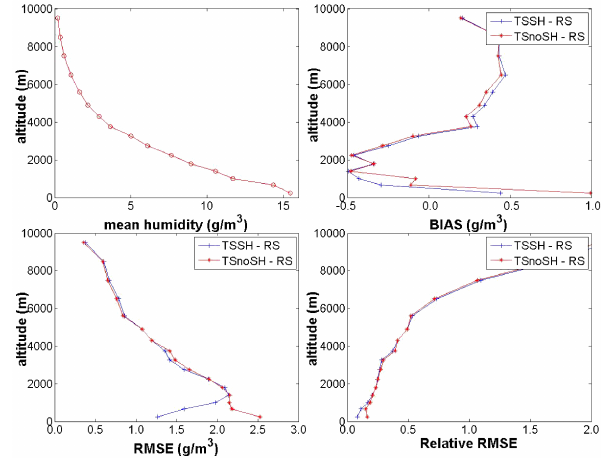
Figure 5. Statistics of the humidity differences between tomo- graphic solutions and RS data in 16 layers. Statistical measures are mean humidity (upper left), BIAS (upper right), RMSE (down left) and relative RMSE (down right).